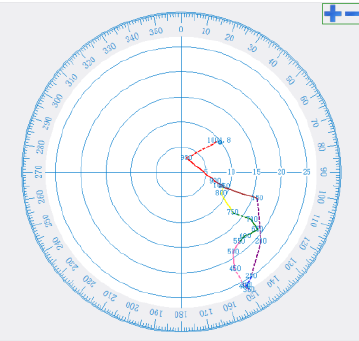
Figure 15. The 17:00 LST Kaiyuan hodograph from the WRF simulations in Domain 2 and surface data.